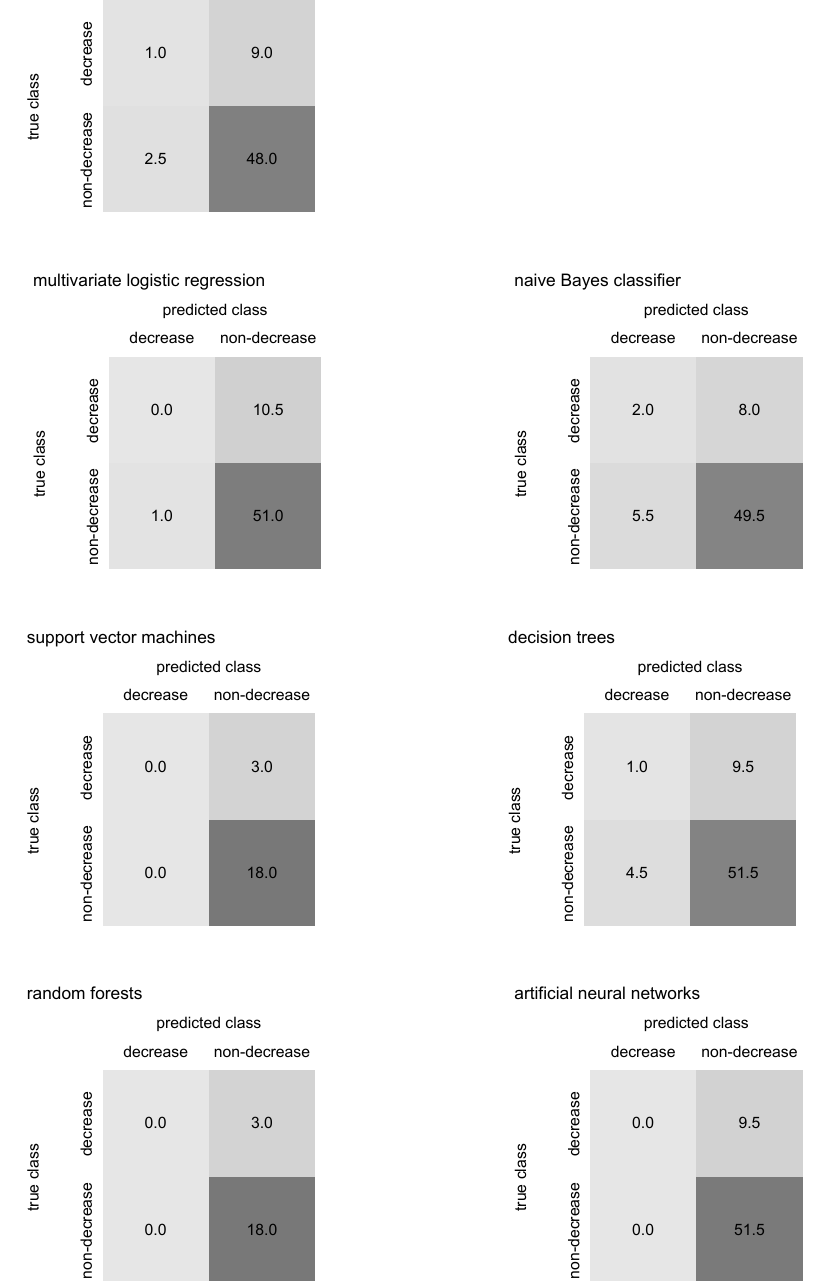
Figure 10. Median confusion matrices for predicting COVID-19 IgG antibody blood level decrease or non-decrease below laboratory cut-off using the listed